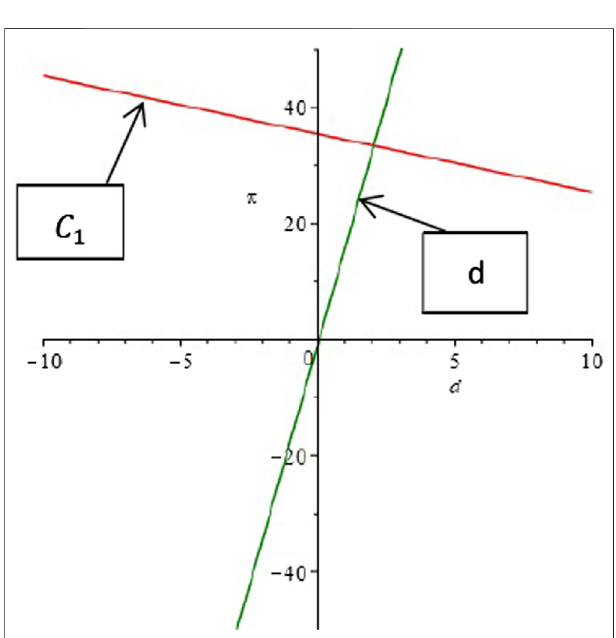
FIGURE 3 | The relationship between enterprise E 1 income π 1 with C 1 and d